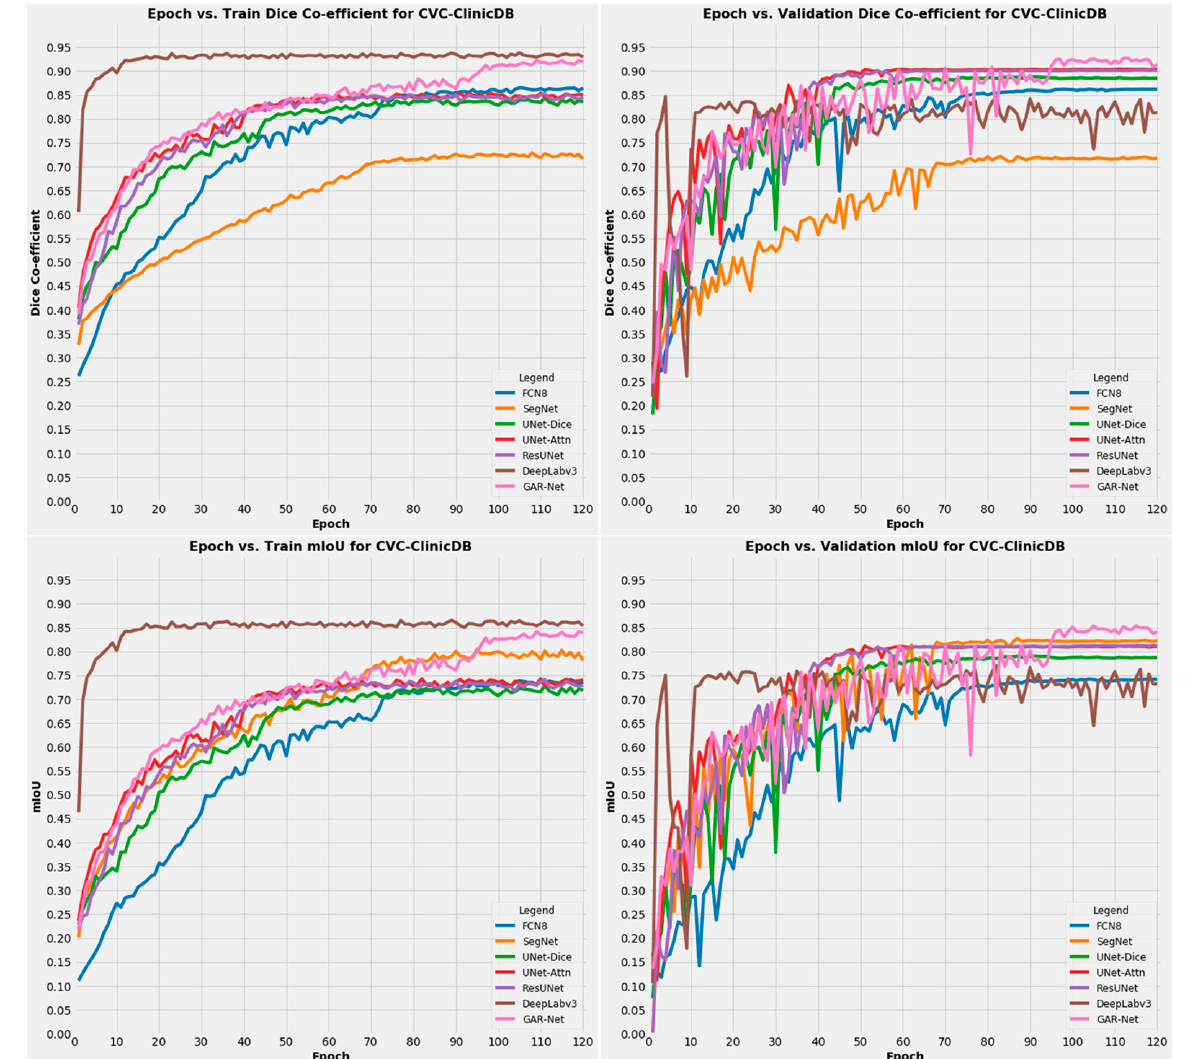
Figure 5. Training and Validation results on the CVC-ClinicDB dataset.